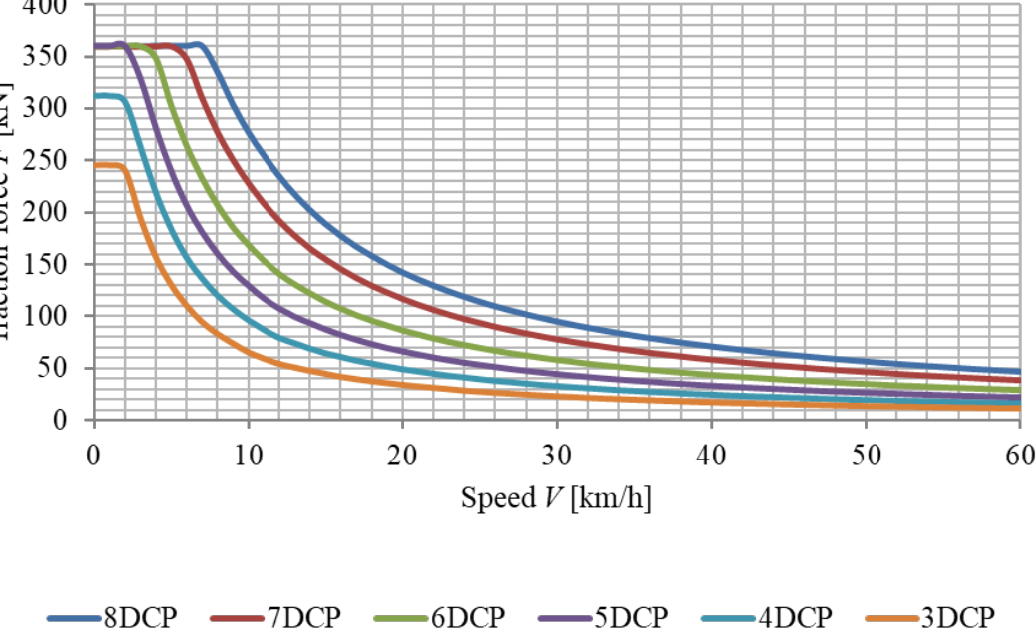
Figure 8. Estimated traction characteristics of the ChME3 locomotive by traction asynchronous electric motors (3DCP-8DCP—position number of the driver’s controller from 3 to 8 respectively). Source: own work.